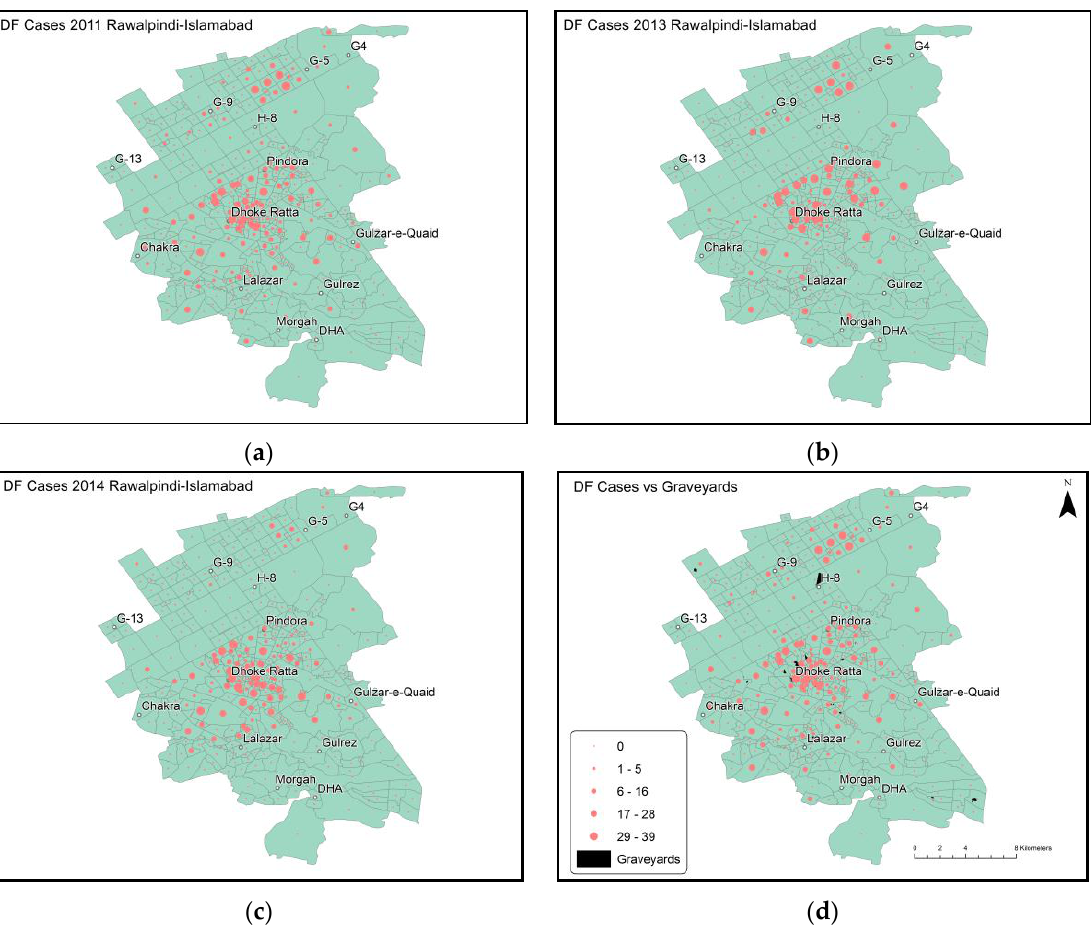
Figure 8. Spatio-temporal analysis for Rawalpindi-Islamabad and its relationship with graveyards.